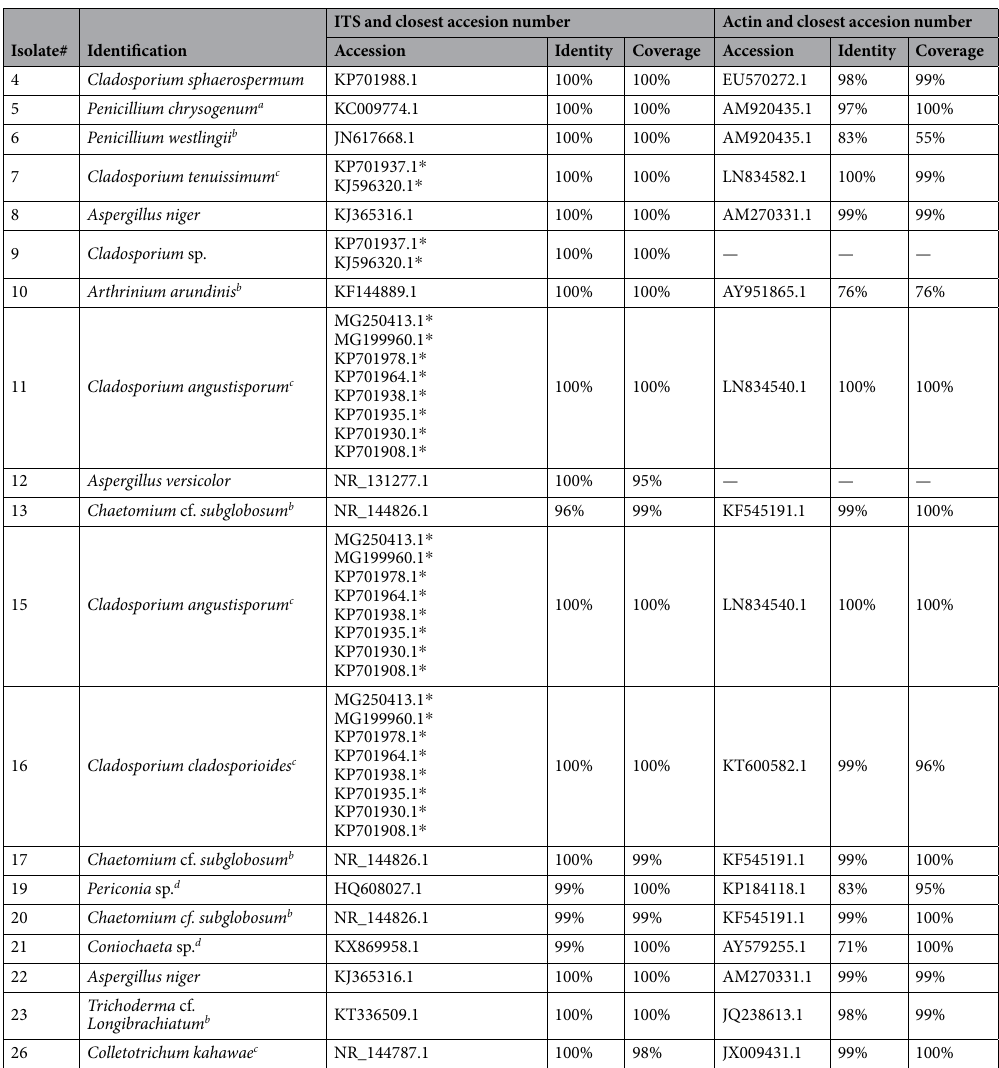
Table 1. Molecular identification of isolated fungi using ITS and actin regions. a Isolates had homology with two fungi of different species with the ITS region analysis, but through sequencing of the actin region it was possible to confirm the identification. b No register in the NCBI GenBank database for actin sequencing regions. c ITS region sequencing allowed to identify only the isolates at genus level; the actin region enabled an identification at specie level. d No register in the NCBI GenBank database for either ITS or actin sequencing regions. * Accessions with same